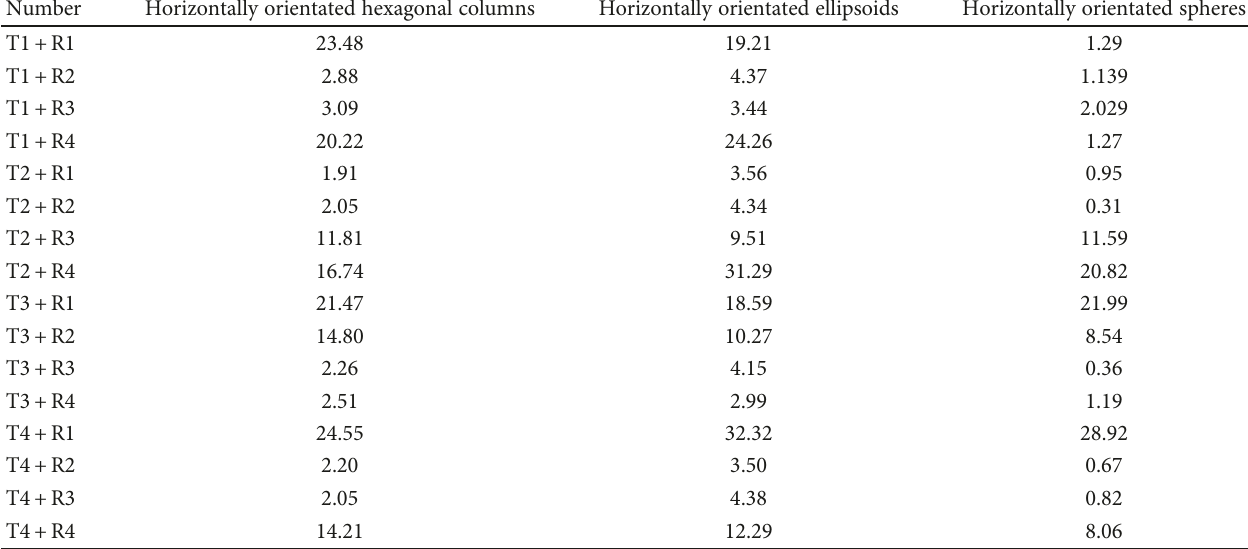
Table 3: The di ff erence between the maximum and minimum RCS fl uctuation by means of MIMO (units: dB). Number Horizontally orientated hexagonal columns